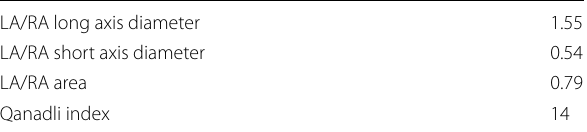
Table 8 Correlation of atrial parameters with Qanadli Index in Table 9 Correlation of atrial parameters with Qanadli Index